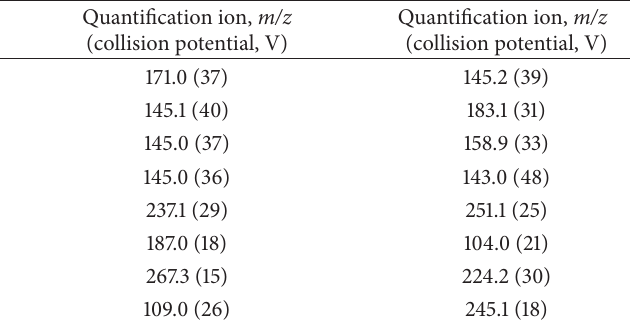
Table 2: Mass spectrometer parameters for the determination of target analytes.